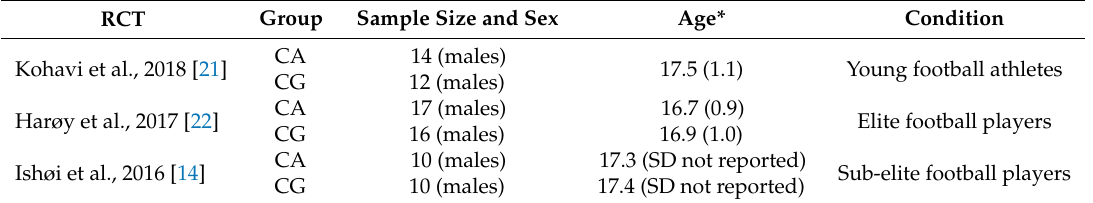
Table 1. Characteristics of the sample.